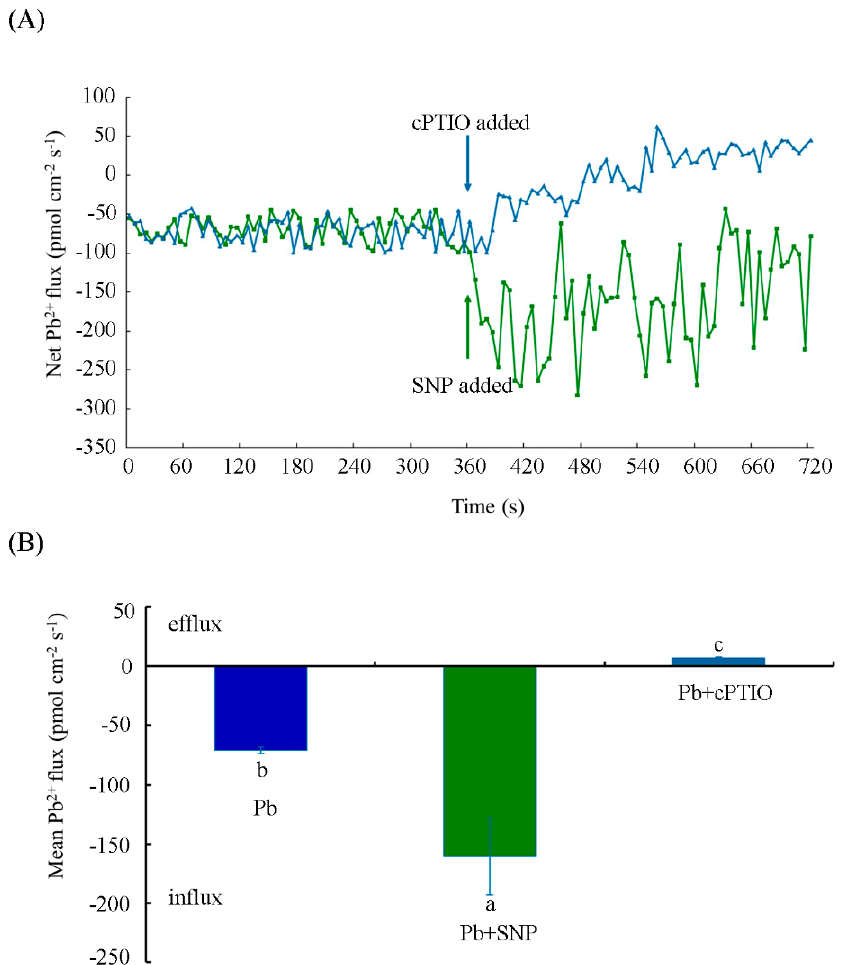
Figure 5. Influence of NO on Pb 2 + fluxes in tobacco BY-2 cells before and after applications of SNP and cPTIO under Pb stress. ( A ) Net Pb 2 + fluxes in tobacco BY-2 cells incubated with 250 µ M Pb(NO 3 ) 2 and then 0.5 µ M SNP (or 100 µ M cPTIO) applied at 360 s to investigate the fluctuation of Pb 2 + flux. ( B ) The mean rate of Pb 2 + fluxes in tobacco BY-2 cells treated with 250 µ M Pb(NO 3 ) 2 in the absence or presence of 0.5 µ M SNP or 100 µ M cPTIO. Di ff erent lowercase letters show significant di ff erence ( p < 0.05).